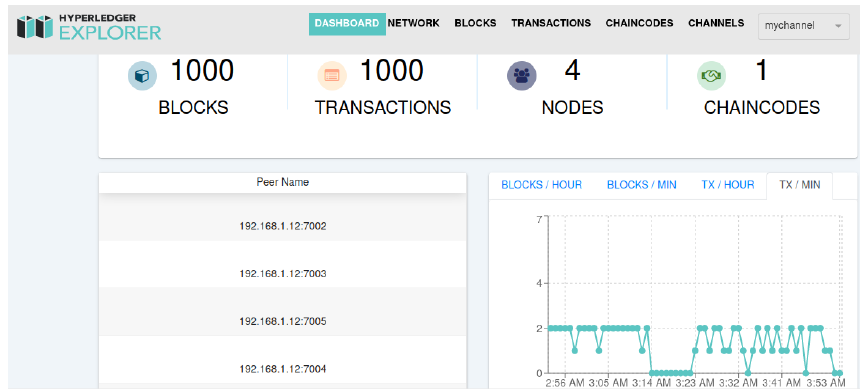
Figure 18. Number of transactions.